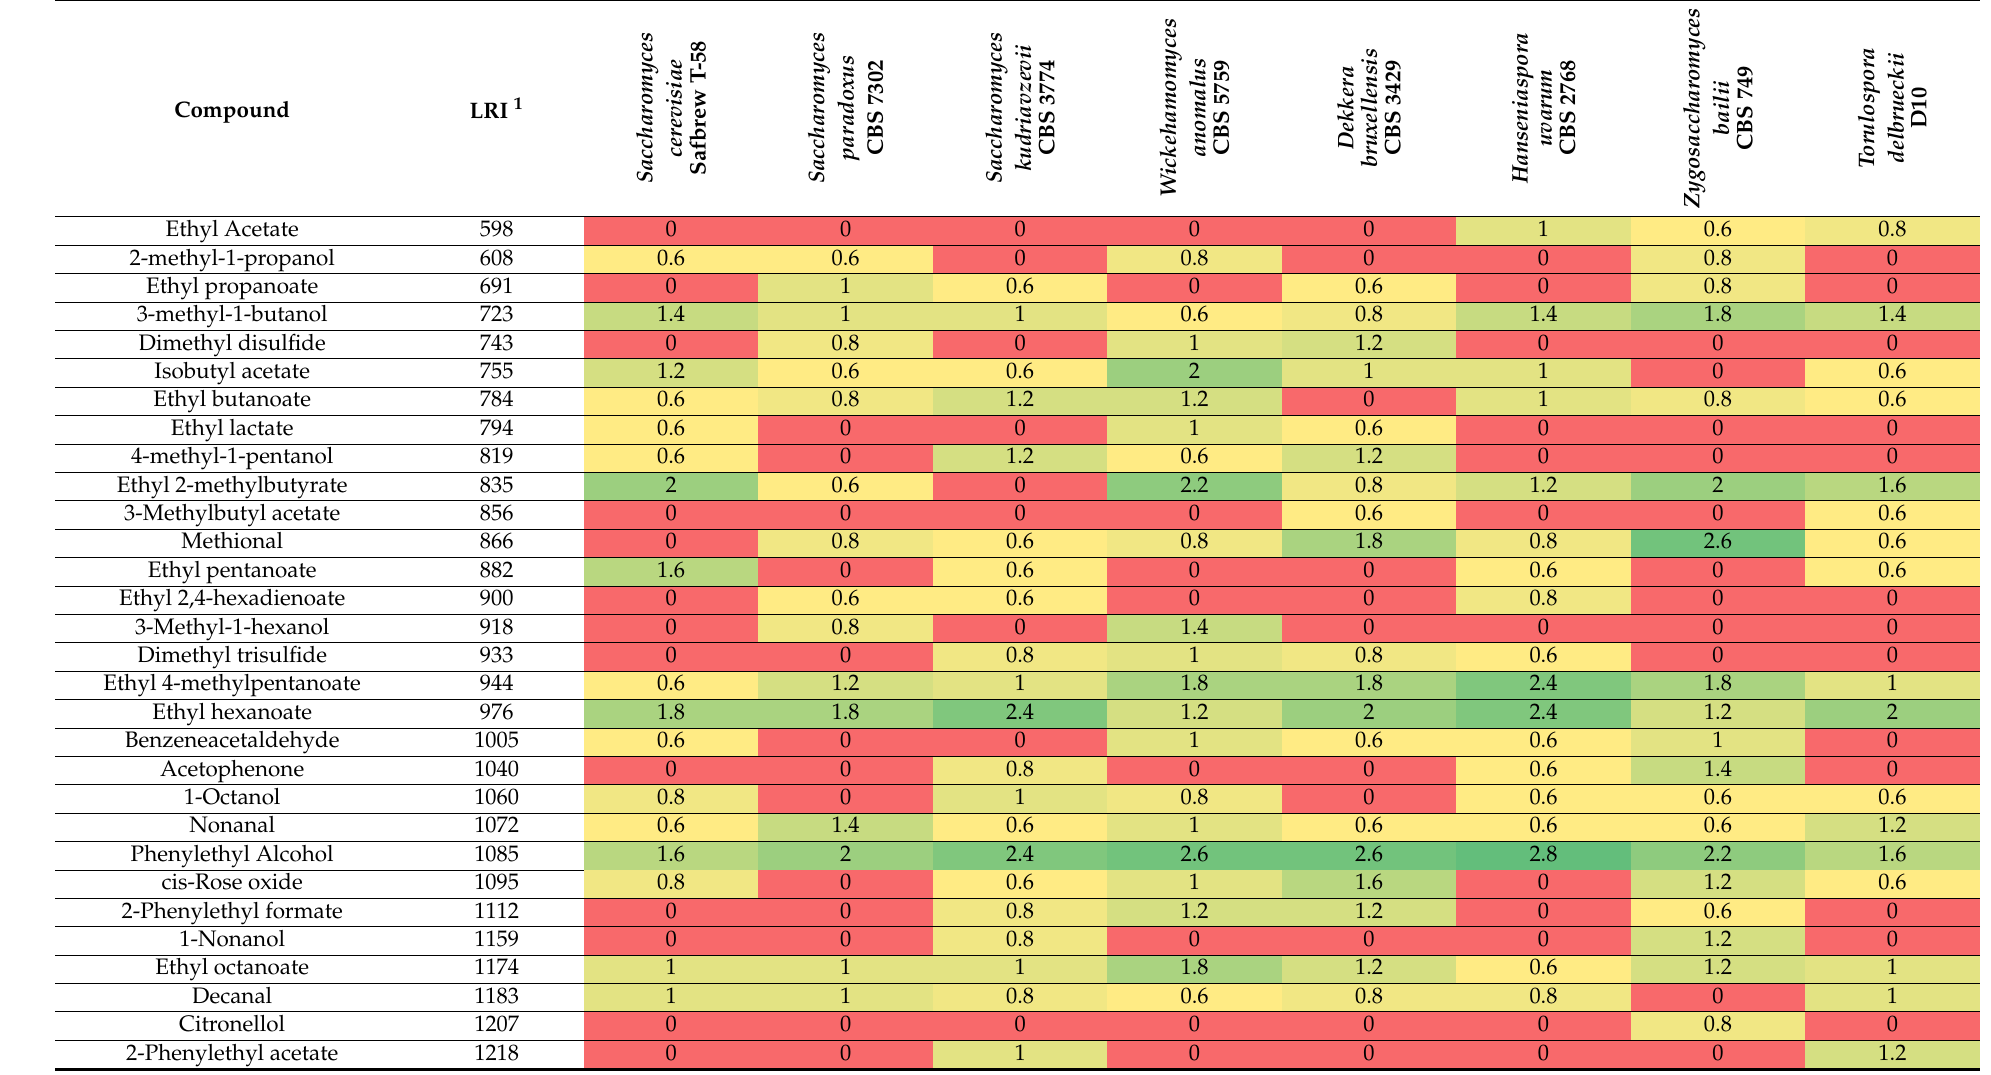
Table 4. Odour-active compounds and heatmap of their intensities detected by GC-O in beers produced with different